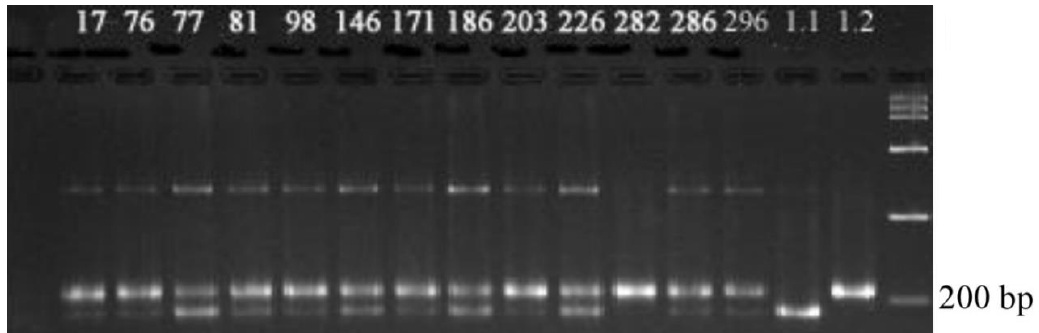
Figure 6. Electrophoregram of genomic DNA amplification products with RM 493: 1.1, Novator; 1.2, NSIC Rc 106; 17–296, hybrid plants NSIC Rc 106 × Novator; DNA marker (100–1500 bp).